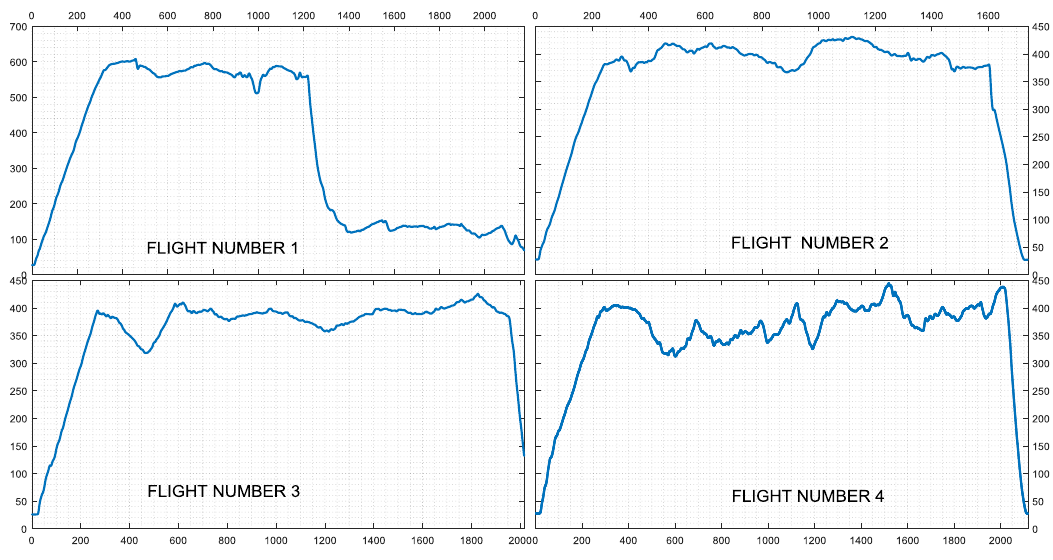
Figure 2. Altitude profiles of the four validation flights.